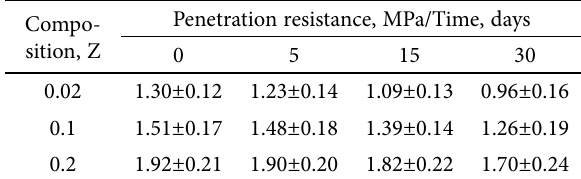
Table 2. Penetration resistance of air-dried glued sandy soil layers xx after exposure in the climatic chamber “Binder” during different time Com po- sition, Z